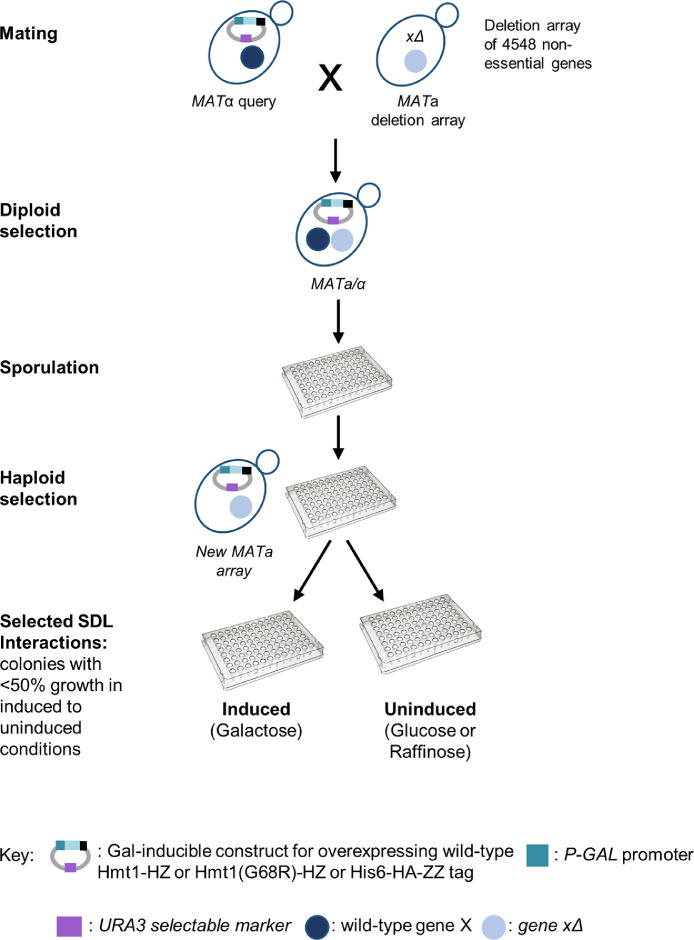
Construction of SDL arrays and collection of SDL Interaction data. Schematic representation of the SDL procedure for the identification of SDL interactions. Haploid cells carrying an overexpressing plasmid of 1) wild-type Hmt1-HZ, or 2) Hmt1(G68R)-HZ, or 3) the HZ (His6—HA-ZZ) tag were mated to an array of 4548 haploid cells with individual gene deletions. After several steps of replica-pinning and selection, an array of haploid cells was isolated that contained the overexpressing construct in combination with a specific gene deletion. The array was then grown on un-induced (glucose or raffinose) and induced (galactose) conditions to identify cells that would show reduced growth phenotype when Hmt1 is overexpressed in a specific gene deletion background.